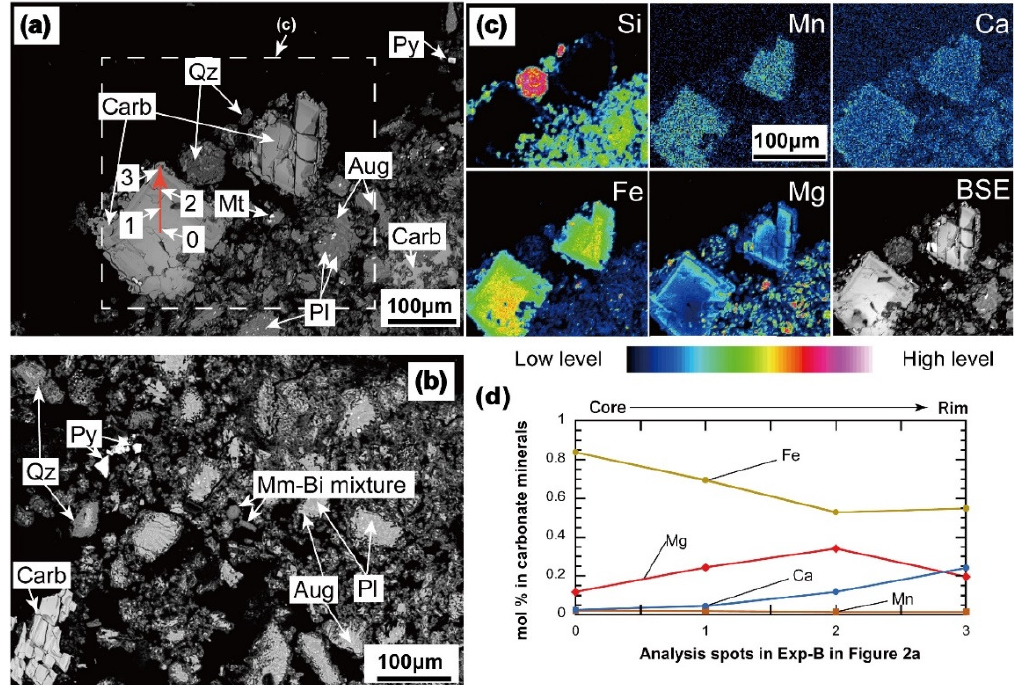
Figure 2. ( a , b ) BSE images of the run products in Exp-B. ( c ) Elemental mapping (Si, Mn, Ca, Fe, and Mg) and BSE image for the area of the square in Figure 2a and ( d ) elemental contents of carbonate minerals in the run products in Exp-B. ( a ) Compositional zonation were observed in carbonate minerals. The brighter and dark regions correspond to Fe and Mg in carbonate minerals, respectively. ( d ) Fe, Mg, Ca, and Mn contents of carbonate minerals at each point of the carbonate minerals in Figure 2a. Abbreviations: Carb—carbonate mineral; Bi—beidellite; Mm –montmorillonite; Py—pyrite; Mt—magnetite; Qz—quartz; Pl—plagioclase. Table 3. Representative compositions of minerals (wt.%) in Exp-B as determined using EPMA. Carbonate Minerals Montmorillonite-Beidellite Mineral Mixture